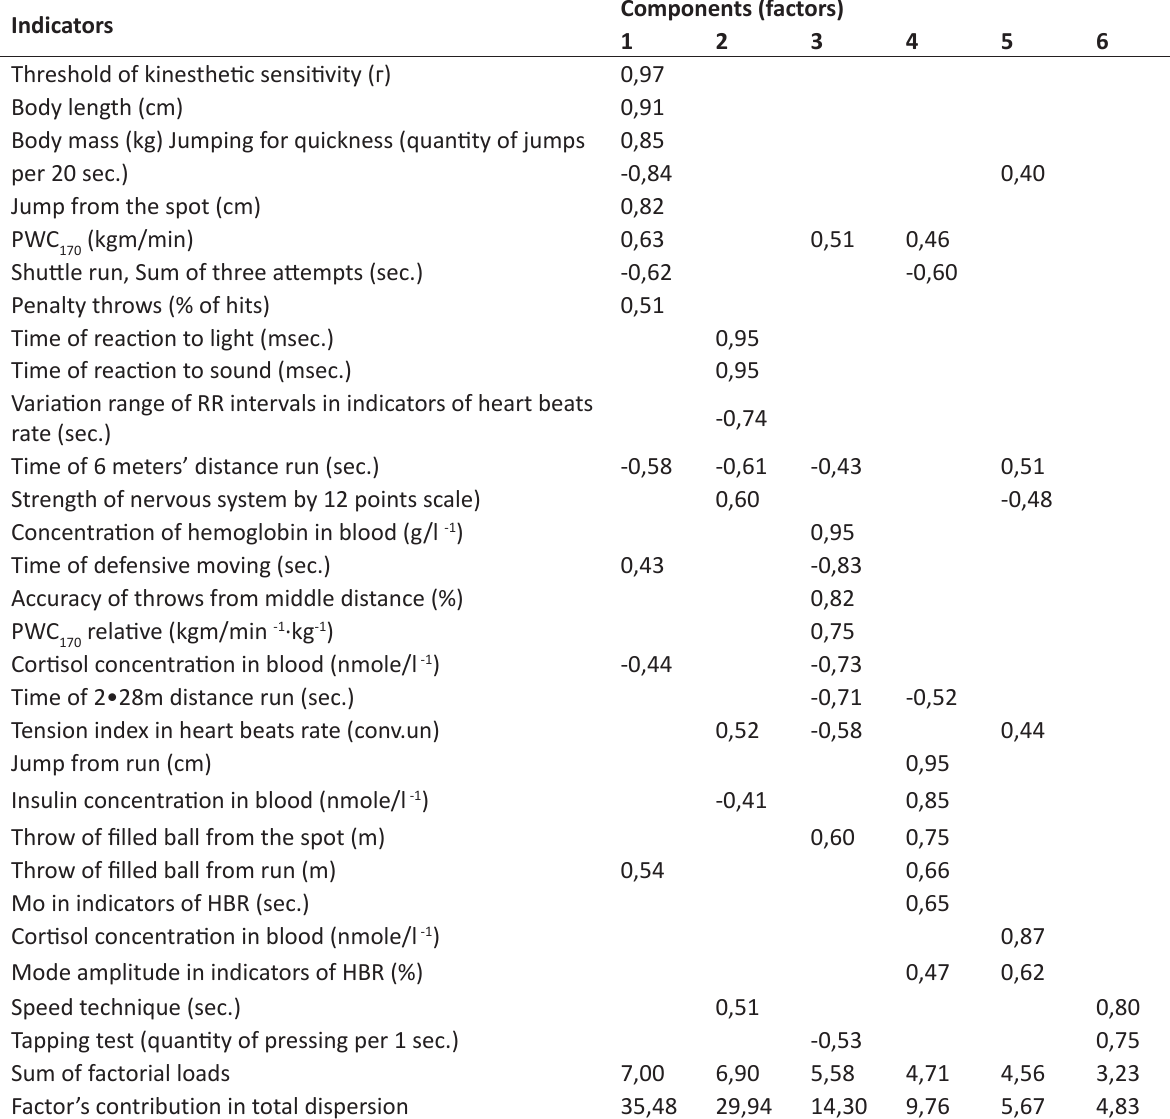
Table 1. Factorial structure of basketball players’ fitness (correlation coefficients more than 0.4 are given) (n=28)